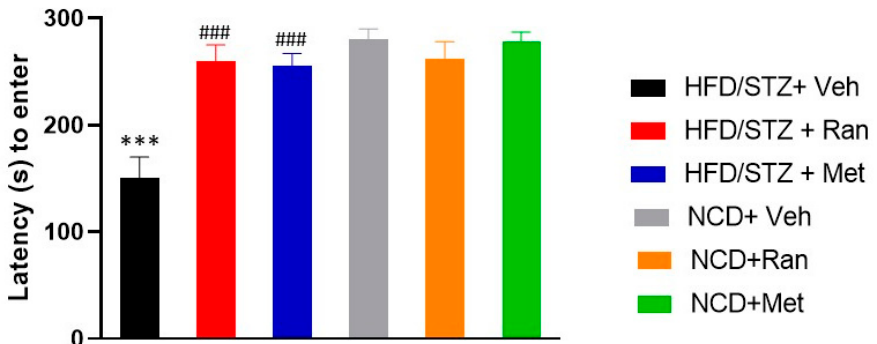
Figure 5. Passive avoidance test (PA). Bars indicate the latency (s) time to enter in the dark chamber during the retention session. Data values are means ± SEM. *** p < 0.0001Significantly di ff erent from NCD / STZ vehicle group. ### p < 0.0001significantly di ff erent from HFD / STZ vehicle group by two-way ANOVA with Tukey’ s post hoc test. NCD = Normocaloric diet; STZ = Streptozotocin; Veh = Vehicle; HFD = High fat diet; Ran = Ranolazine; Met =